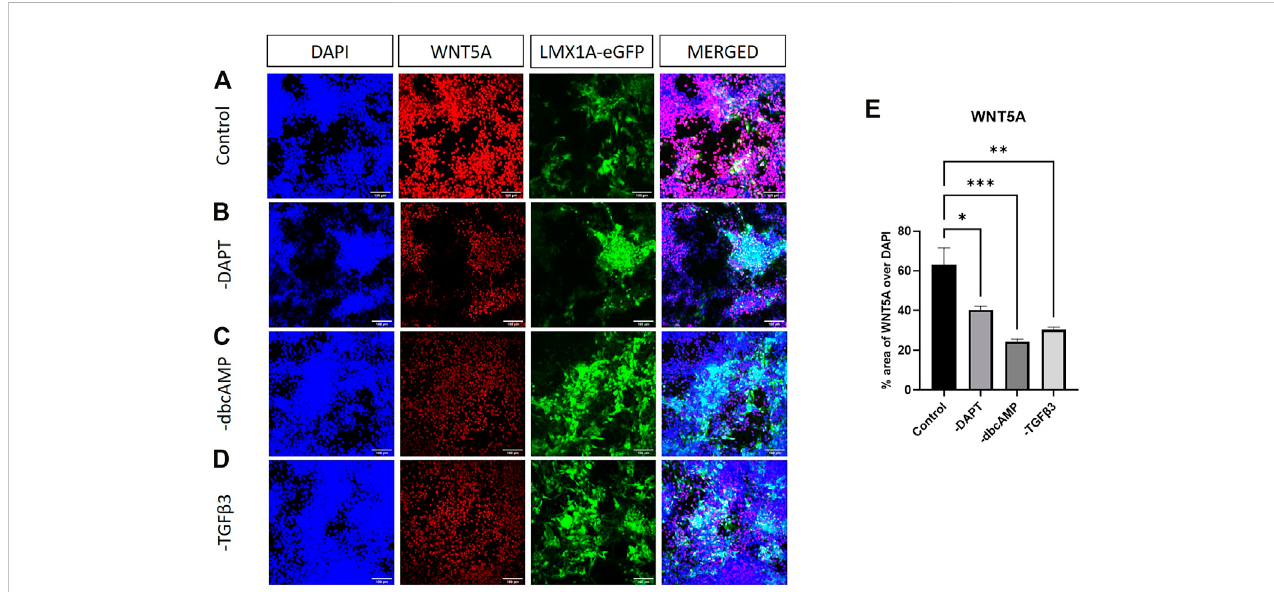
FIGURE 8 Immunolabelling of WNT5A in LMX1A-eGFP cultures. Panel (A) shows, from left to right, DAPI nuclear labelling (blue), WNT5A (red), LMX1A-eGFP fl uorescence (green) and a color combined image (merged). Panels (B – D) show the corresponding data, but following cultivation in the absence of DAPT, dbcAMPandTGF β 3,respectively.Panel (E) showsWNT5A fl uorescenceasafractionofDAPI fl uorescence( n =3).Scalebarindicates100 μ m.Bargraphsshow mean +/- s. e. mean; * = p < 0.05, ** = p < 0.01, and *** = p <